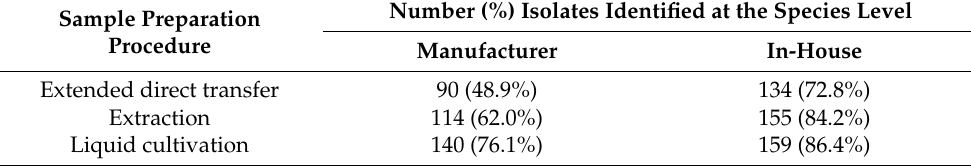
Table 3. Clinical isolates identified at the species level and reference strains included in the Filamen- tous Fungi Library 3.0 ( n = 184). Number (%) of correctly identified isolates at the species level using three different sample preparation procedures. Manufacturer: when applying the manufacturer’s instructions, in-house: when applying a threshold of